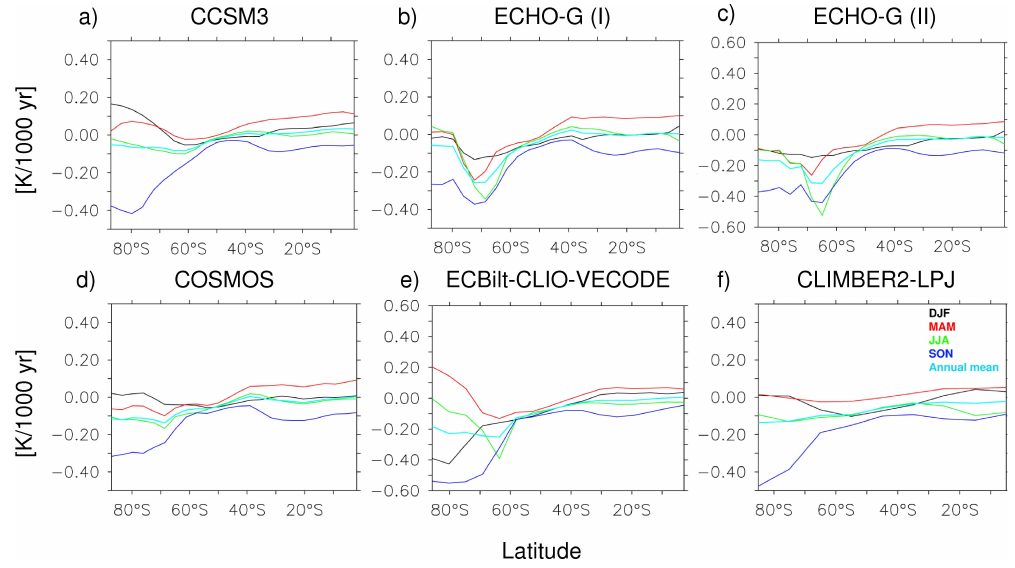
Fig. 7. Zonally averaged seasonal and annual mean trends in the surface temperature in (a) CCSM3, (b) ECHO-G (I), (c) ECHO-G (II), (d) COSMOS, (e) ECBilt-CLIO-VECODE, and (d) CLIMBER2-LPJ for the Southern Hemisphere for the period 7kyr BP to 250yr BP. Note the different ordinate scales.